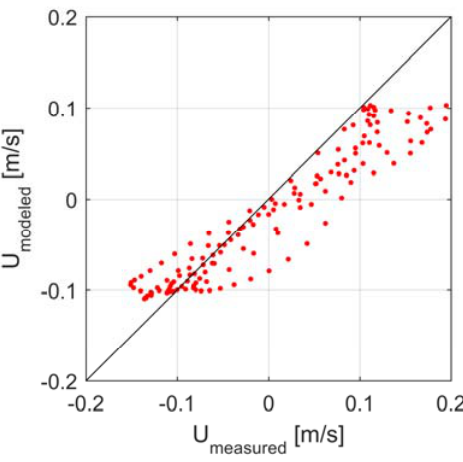
Figure 14. Scatter plot of the measured and calculated velocities for the point closest to the bank (d x = 0.5 cm at the CFD model).